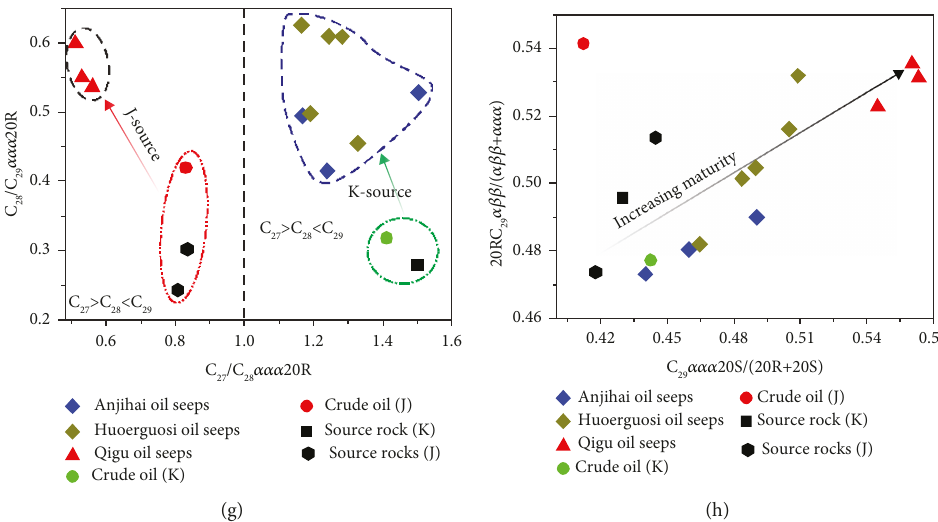
Figure 9: Plots of selected molecular geochemical parameters for oil-seep, crude-oil, and source-rock samples from the middle segment of the southern Junggar Basin. (a) δ 13 C (in ‰ relative to the VPDB standard) vs. Dia/Reg; (b) Pr/Ph vs. G/C C T/C T vs. C 20 21